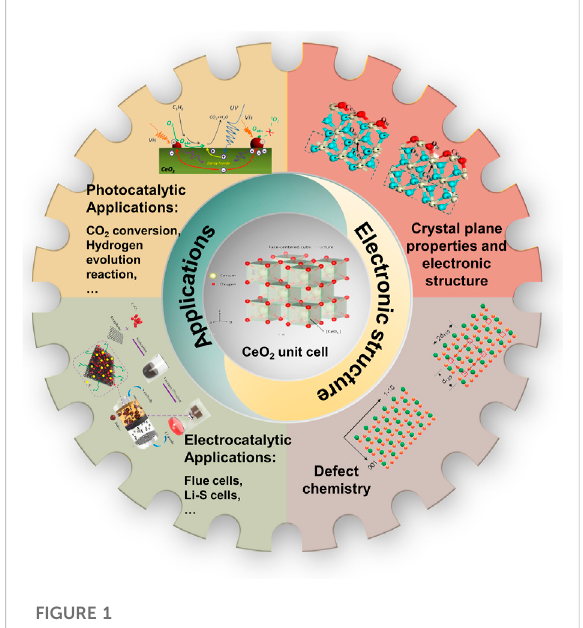
FIGURE 1 Illustration of electronic properties and catalytic applications of CeO 2